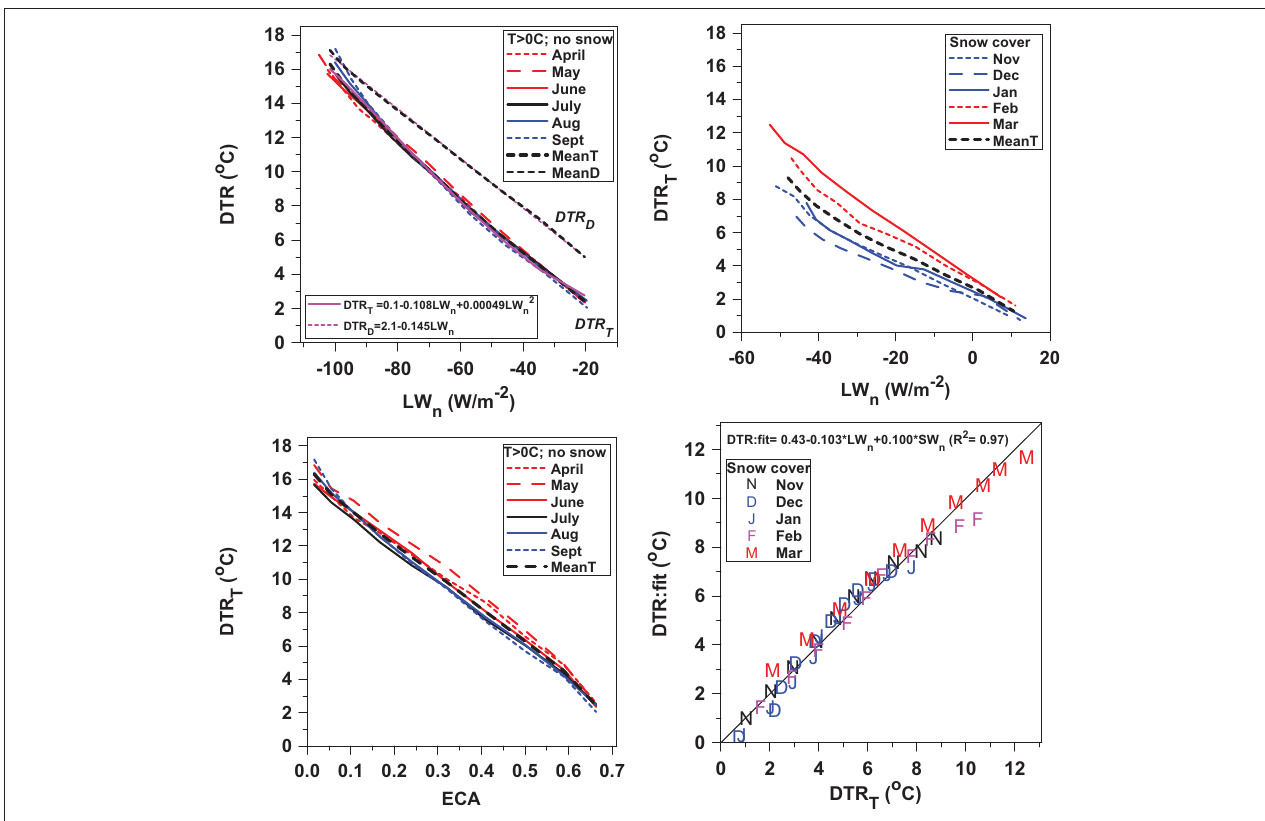
FIGURE 19 | Warm season dependence of DTR T and DTR D on LW n (top-left) and ECA (bottom-left); cold season dependence of DTR on LW n (top-right) and (bottom-right) cold season regression fit to LW n and SW n .